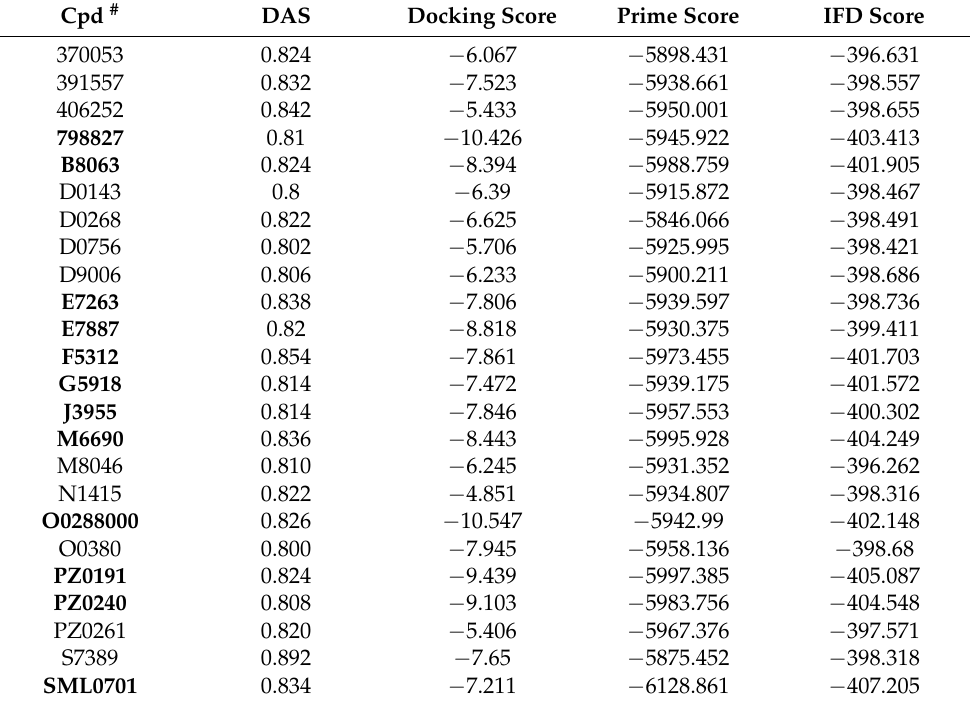
Table 1. Ligandandstructure-basedoutputresults. DAS:DRUDITaffinityscore; IFD:induced-fitdocking. Cpd # DAS Docking Score Prime Score